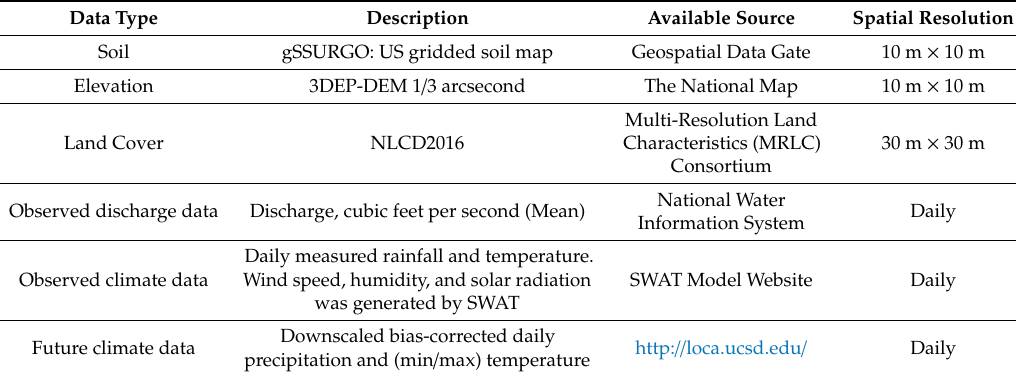
Table 2. Soil and Water Assessment Tool (SWAT) Input